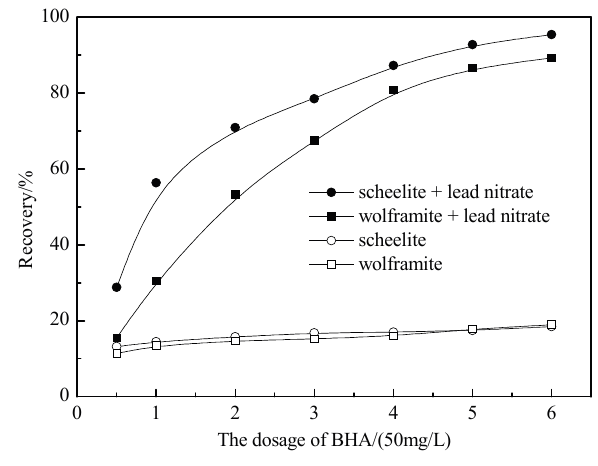
Figure 2. Recovery of scheelite and wolframite as a function of collector dosage.